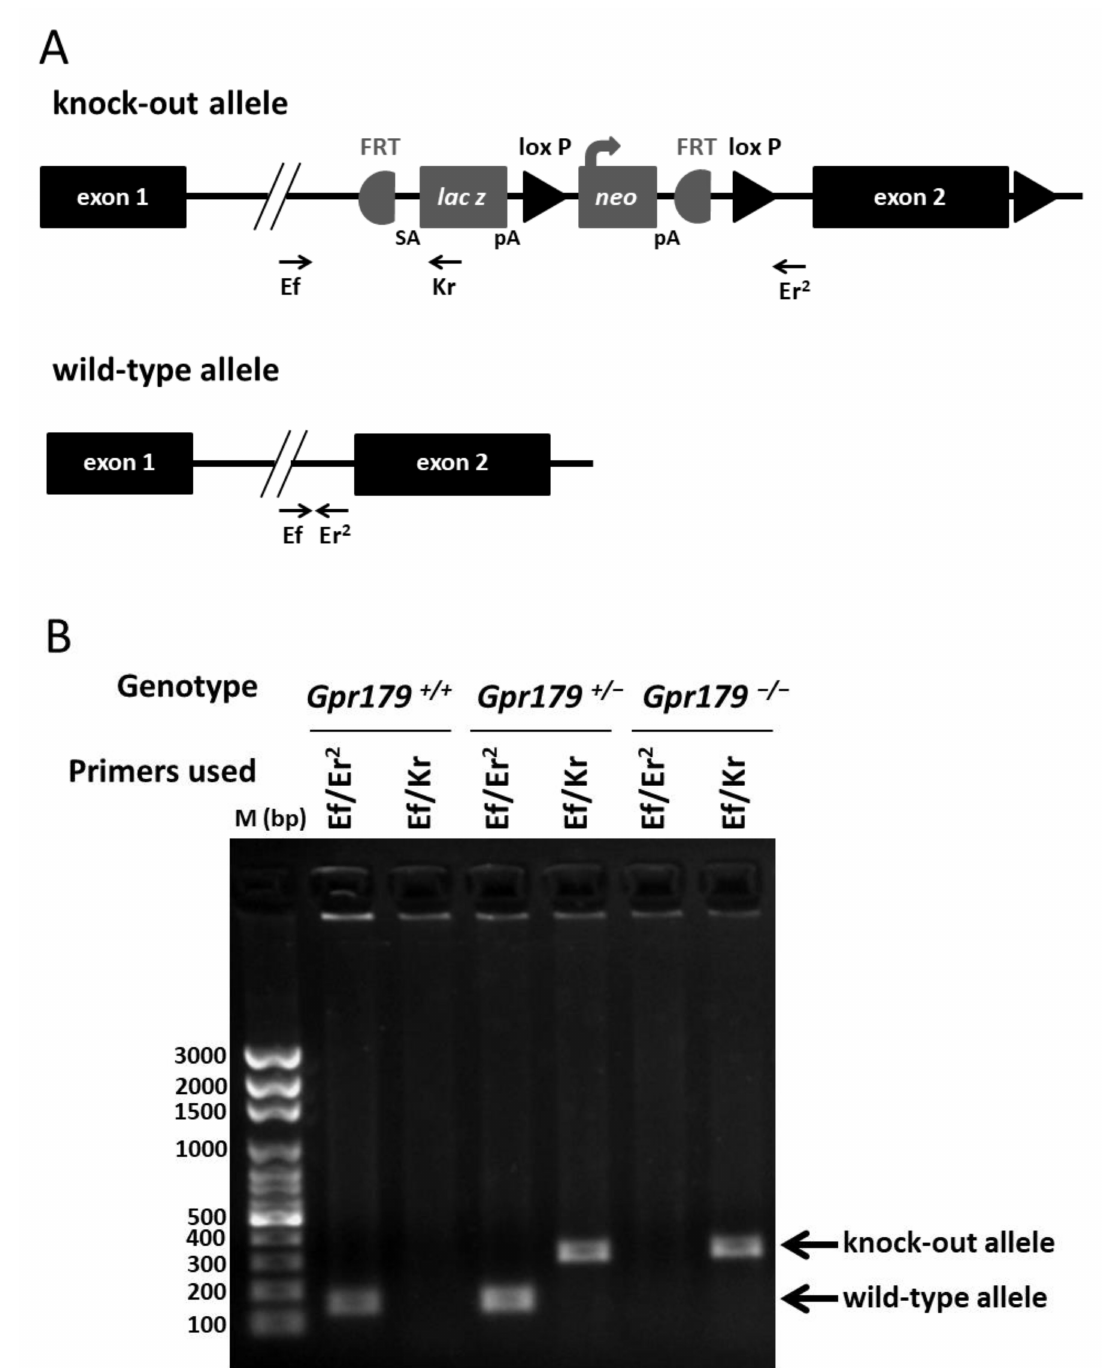
Figure 1. ( A ) Schematic drawing of the wild-type allele and the knock-out allele with the construction inserted in intron 1. Abbreviations: FRT: flippase recognition target, SA: signal anchor, lacZ : lactose operon, pA: polyadenylation site, neo : neomycin. M bp: marker base pair. For genotyping, mGpr179 _Ef (Ef) and mGpr179 _Er2 (Er2) primers were designed to amplify a 146 bp product on wild-type allele. Ef and mGpr179 _Kr (Kr) primers were designed to amplify a 303 bp product on knock-out allele. ( B ) After migration on 1% agarose gel, Gpr179 +/+ exhibited a single fragment at the expected size of 146 bp, Gpr179 − / − exhibited a single fragment at the expected size of 303 bp, and Gpr179 +/ − exhibited both